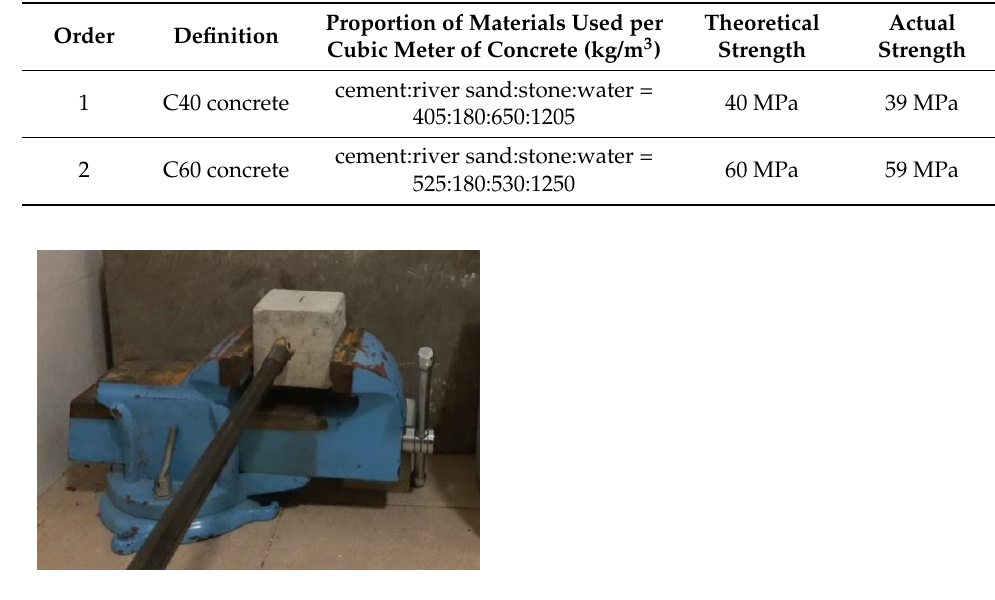
Figure 13. The similar material to roof